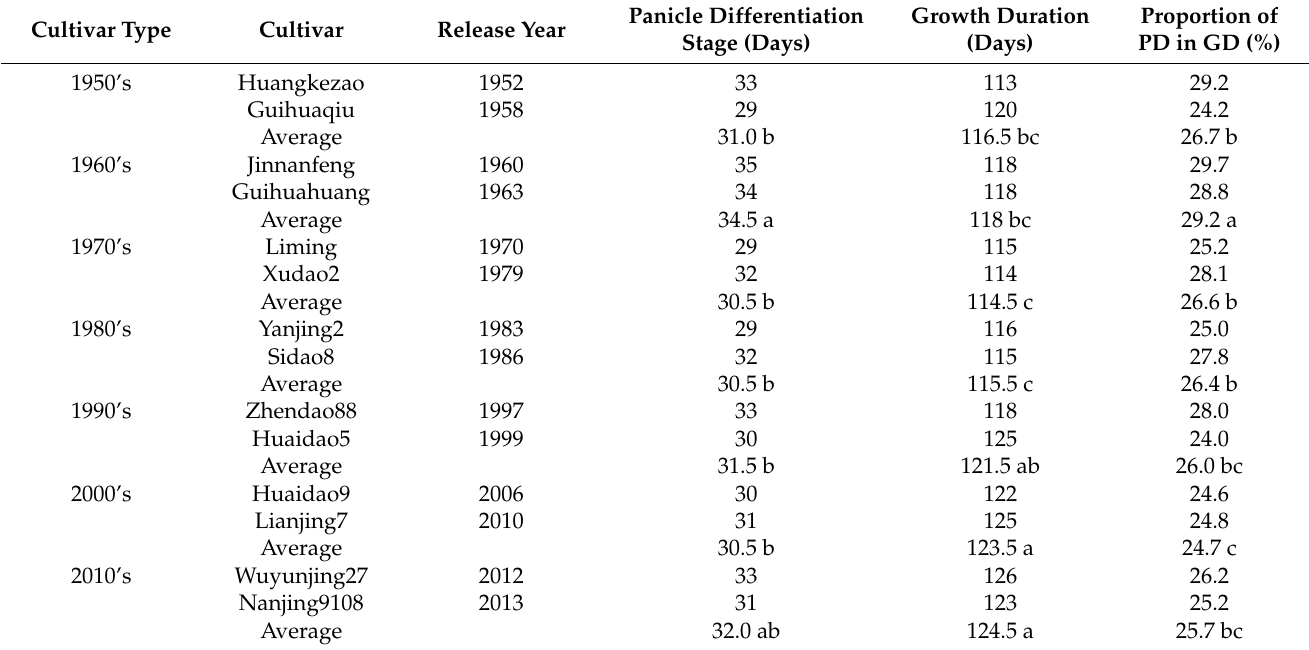
Table 1. Release year and growth duration of the selected Japonica rice